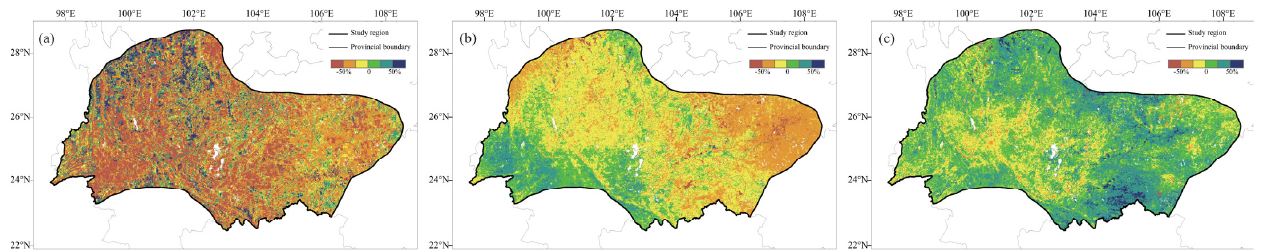
Figure 5. The spatial distributions of NPP anomaly percentage in spring (March–May) of 2010 ( a ), 1999 ( b ), and 2013 ( c ) relative to the average for the period 2000–2009. When it comes to the distribution of annual NDVI anomaly percentages, the majority of the study region shows weak negative anomalies in annual NDVI due to the lagging effect of concurrent events (Figure 6). Over 63% of the areas showed a decrease in annual NDVI in 2010 compared to the average for the 2000–2009 period, with an average decrease of 2.23% on a regional scale, while nearly 75% of the areas showed a decrease in annual NDVI in 1999, with an average decrease of 1.95% on a regional scale. Half of the areas showed a decrease in the annual NDVI in 2013, with the overall regional scale being in line with the average. In contrast to the clear trend in spring NDVI with the intensity of concurrent events, the trend in annual NDVI is not as pronounced, partly since annual vegetation greenness is also influenced by summer and autumn weather, and the decline in NDVI in the study region was somewhat mitigated by more precipitation than the same period after August 2010, when temperatures were essentially flat. Spatially, the distribu- tion of annual NDVI anomaly percentages is generally consistent with that of spring, al- beit with slightly lower intensity.